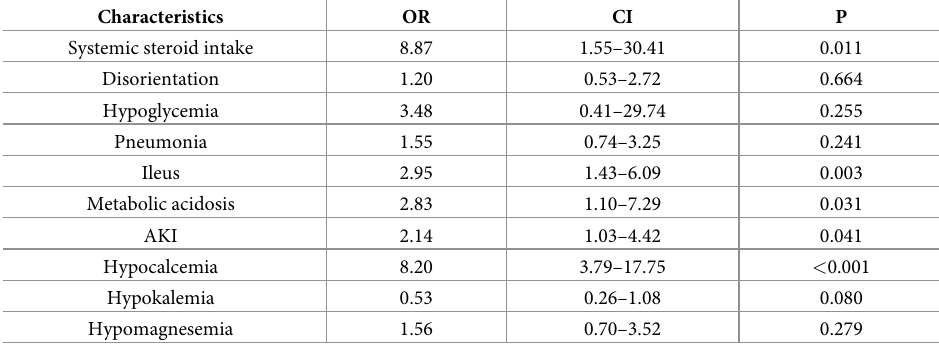
OR = odds ratio, CI = confidence interval, AKI = Acute kidney